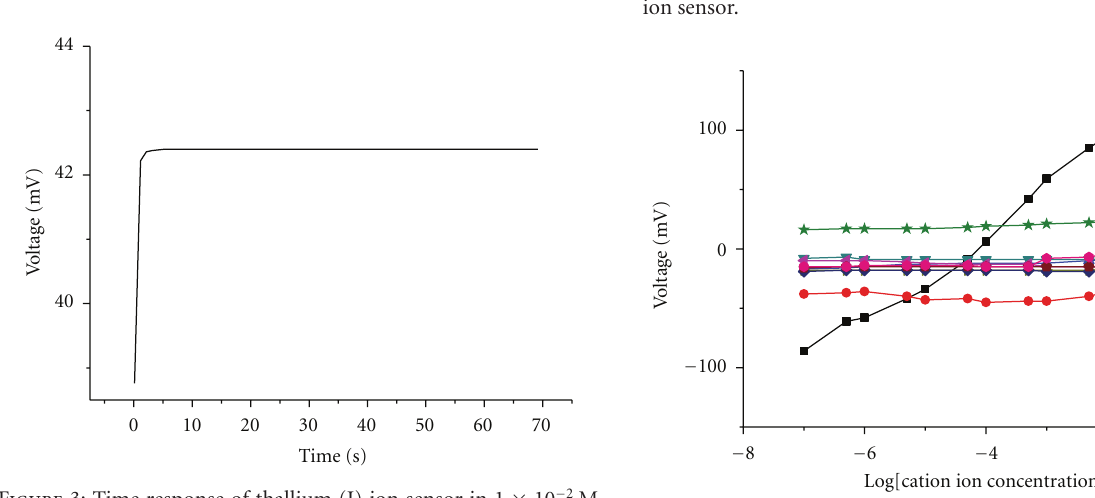
Figure 3: Time response of thallium (I) ion sensor in 1 × 10 − 2 M solution of thallium nitrate.